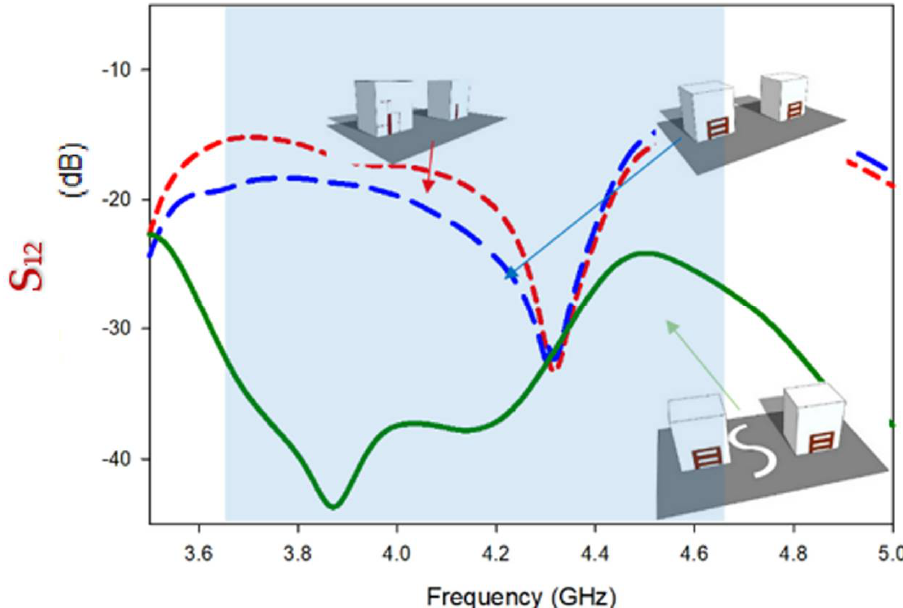
Figure 14. Comparison of mutual coupling reduction in Design-1, Design-2, and the proposed design.